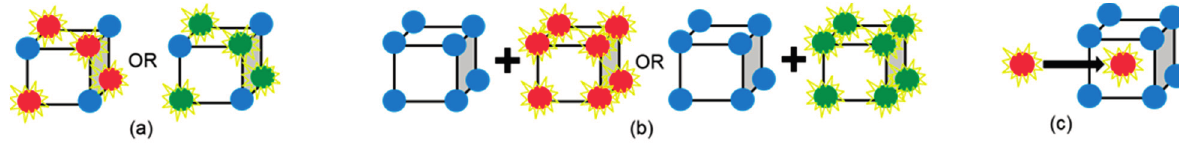
of a second Ln element into a Nd based-MOF.